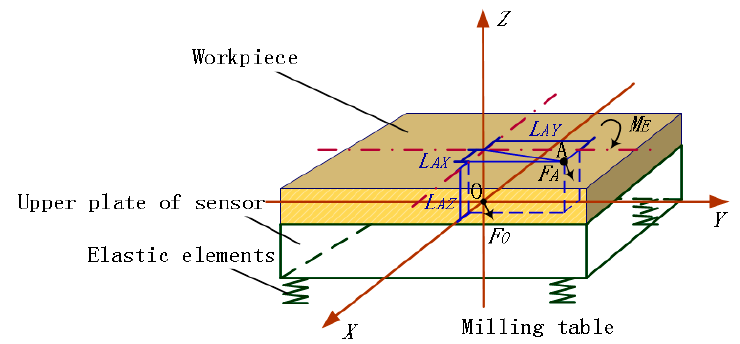
Figure 1. Diagram of eccentric force applied on a fixed dynamometer.